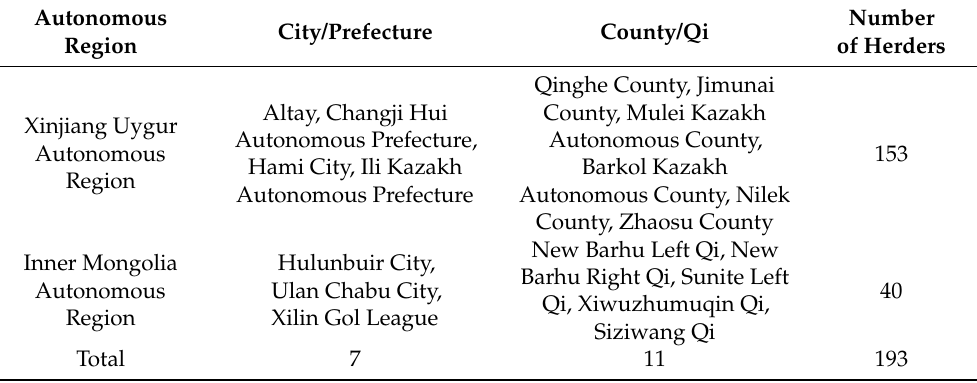
Table 1. Sample numbers and